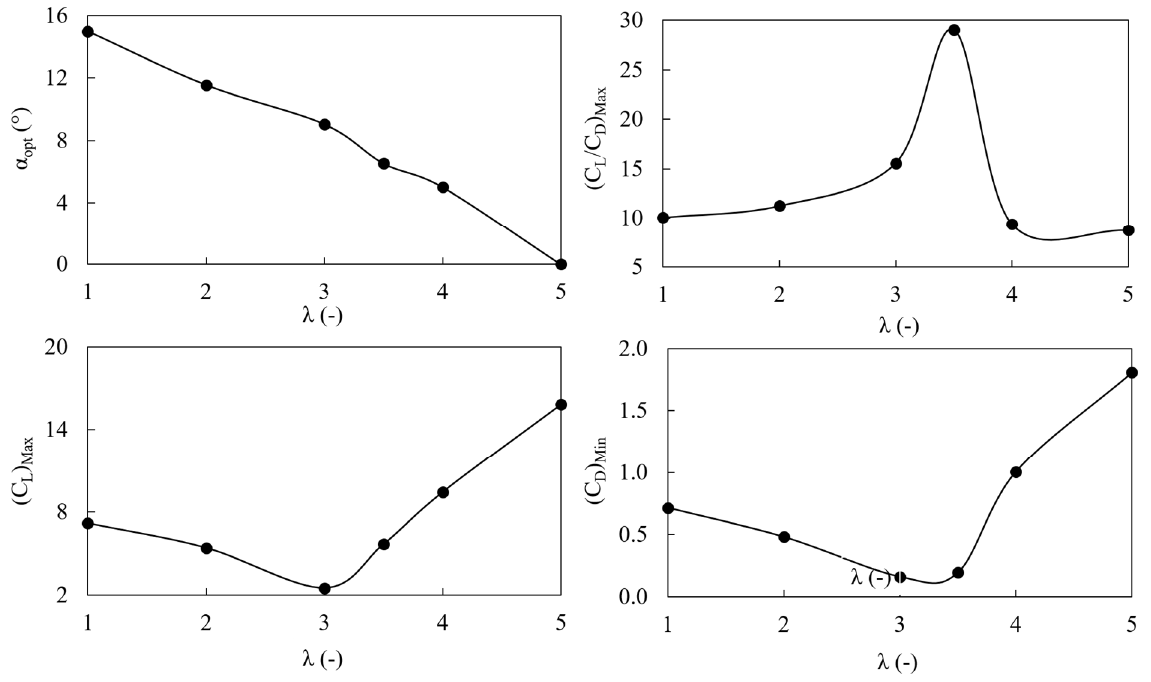
Figure 9. Optimized values of aerodynamic parameters for all TSRs.